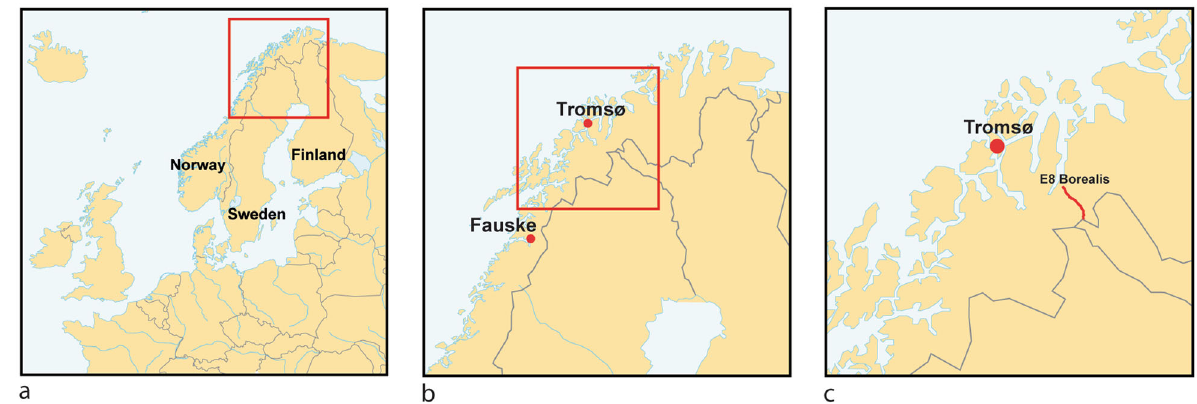
Fig. 1 Location of the Borealis project. a Norway ’ s placement in Northern Europe. b The terminal points of the proposed Northern Norway railway